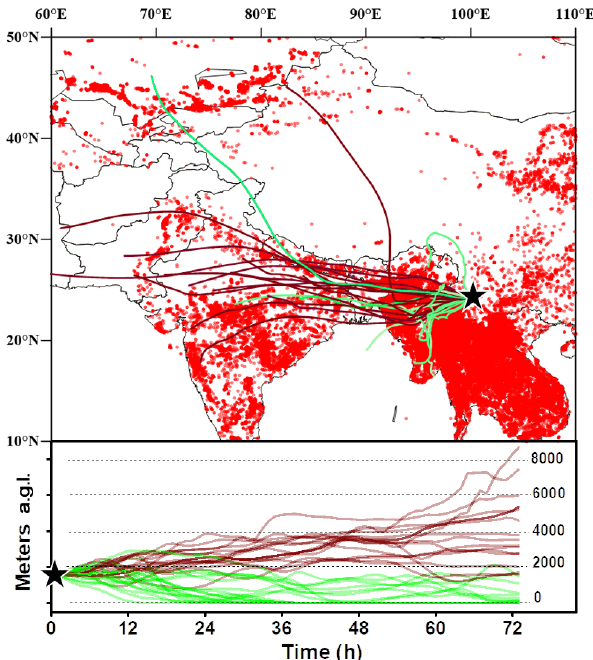
Figure 4. Spatial distribution of the fire spots observed by MODIS, as well as the corresponding 72h backward air-mass trajectory clus- ters arriving at 1500m above ground level (a.g.l.) during the sam- pling periods for the collected samples. The backward trajectories were separated into two episodes of remote western source above 2000m and local western source below 2000m, as shown in wine red and green